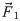
Relationship between gamma phase shifts and movie features within the RFs.(A) Principle of the computation of correlation between gamma phase shift of a strongly asymmetric channel pair and movie features (the local TC in this cartoon) measured in the RFs of each electrode in the pair. We extract the contrast time course from the movie data for each RF, symbolically represented over a movie frame, and check whether it is related to gamma phase shift time series for the corresponding electrode pair, by computing correlation across time between the two quantities. The same procedure is applied to the sum and the difference between features from the two RFs. (B) Example of optic flow estimation on one movie frame. Optic flow is estimated on a homogenous grid spreading over the frame. Nonvanishing optic flow estimates are indicated by a red arrow, and vanishing ones are indicated by a black dot. The schematic representation of the movie frame shows a sketch of the sky (light blue on top), the sea (dark blue at the bottom), an island (light green, center and right-hand side), and a remote landscape in the background (dark green, left-hand side). As the camera goes forward towards the island, the optic flow estimation correctly detects a movement of the landscapes towards the sides of the frame. (C) Principle of the computation of the correlation between gamma phase shift of an electrode pair and the directed motion along the inter-RF axis of this pair, derived from the optic flow vector F→1 estimated in the sending recording site. The “+” superscript denotes the positive part. (D) Correlation across time between movie features (either a feature in an individual RF, sending or receiving, or the sum or difference of these features) and gamma phase shifts, averaged across asymmetric channel pairs. Local TC, OA, and directed motion are considered here as movie features. Stars indicate significant correlation values (signed rank test; p < .05). (E) Correlation across time between MUA activity and different movie features (TC or OA) in the RF, averaged across all electrodes. Stars indicate significant correlation values according to a signed rank test (p < .05). (F) Correlation across time of different variables derived from MUA activities of a channel pair (either a feature in an individual RF, or the sum of MUA in the sending and receiving RFs, or difference between MUA in the receiving and MUA in the sending RF) and the gamma phase shift of the pair, averaged across asymmetric electrode pairs. Stars indicate significant correlation values (signed rank test; p < .05). Data available at http://dx.doi.org/10.6084/m9.figshare.1460872.